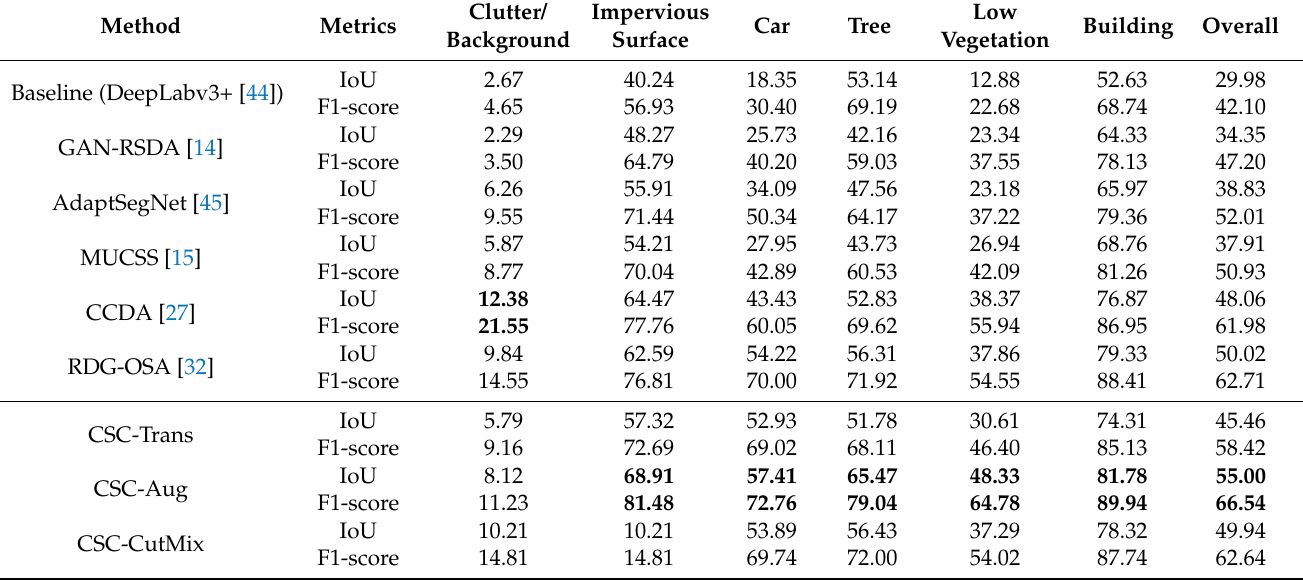
Table 1. Quantitative results (%) of cross-domain semantic segmentation on Potsdam RGB → Vaihin- gen IRRG benchmark.